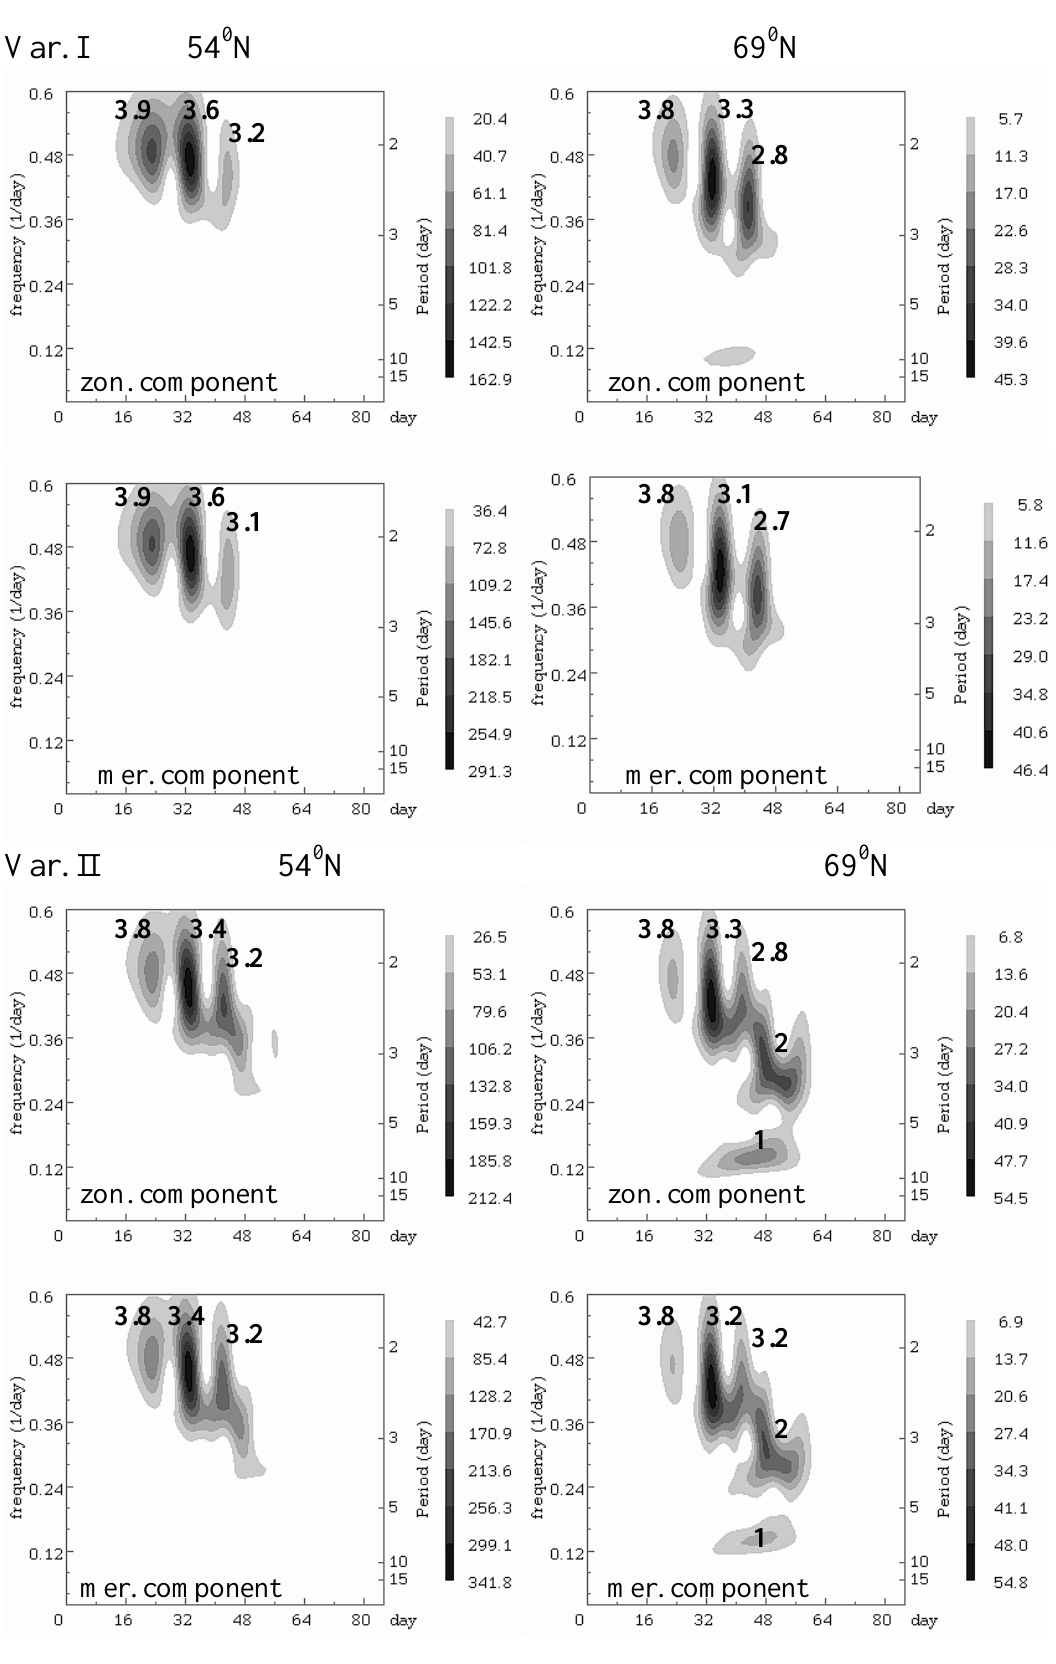
Fig. 9. Results of numerical oscillations for two different locations of the 2-day wave